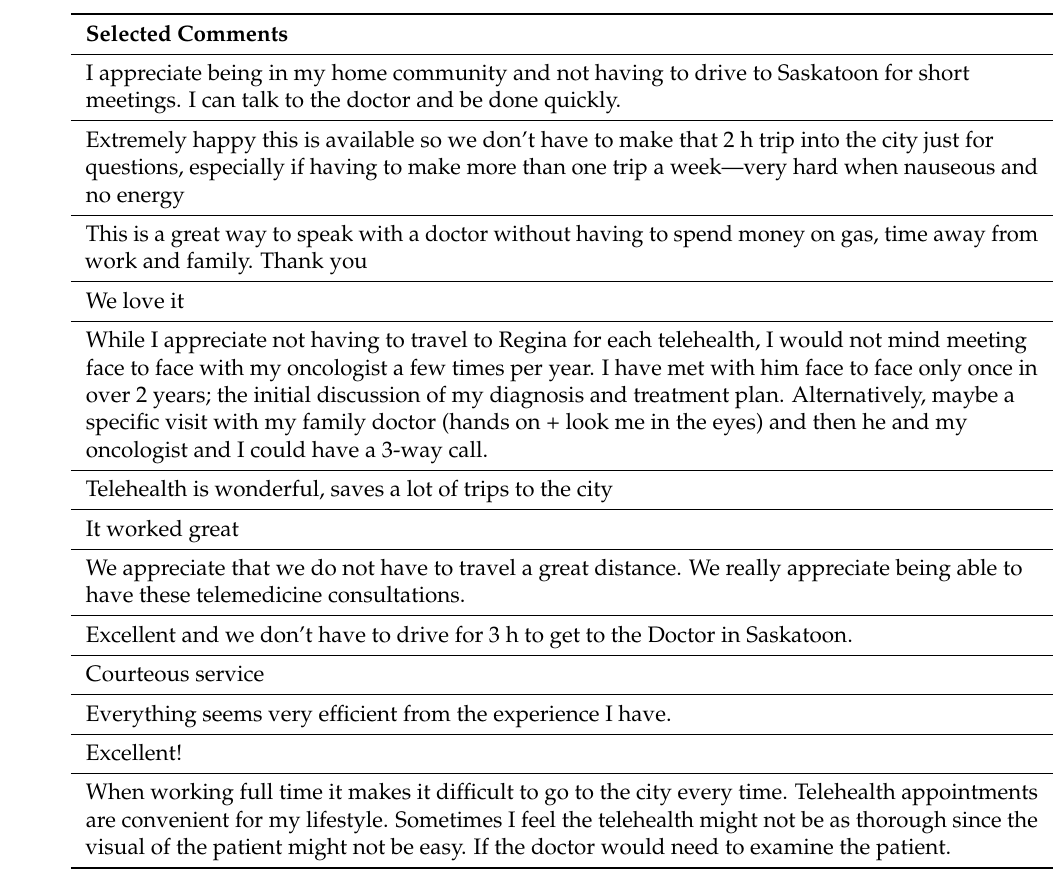
Table 5. Selected comments by the patients who used